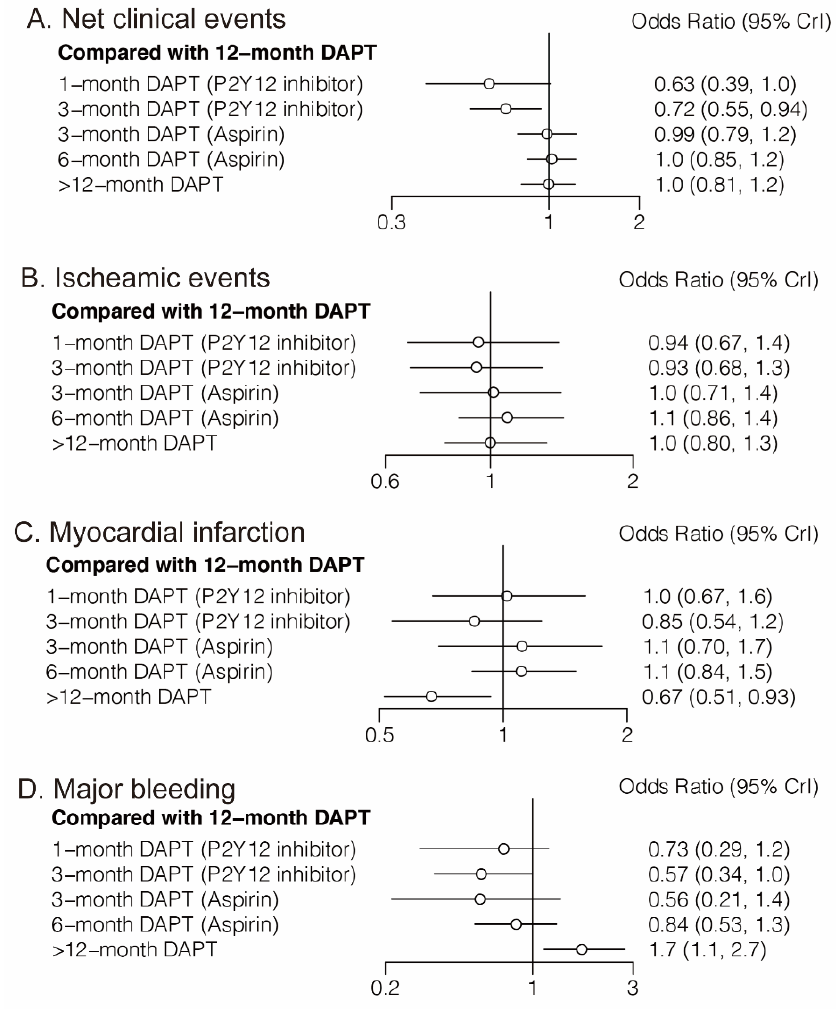
Figure 2. Network Meta-Analysis for Primary Outcomes.